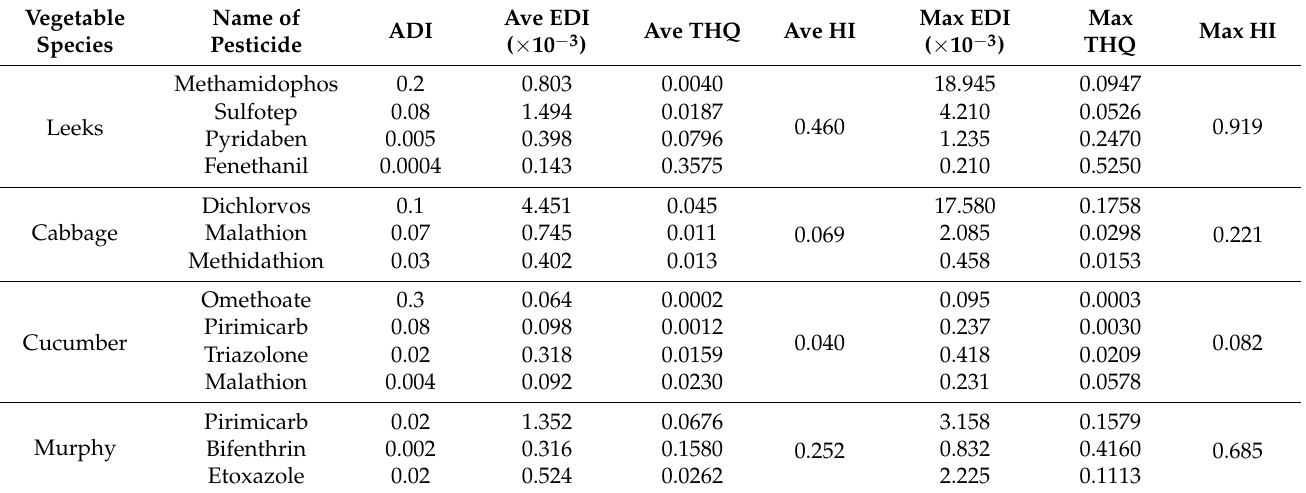
Table 6. Assessment of each pesticide intake and associated health risks among the four